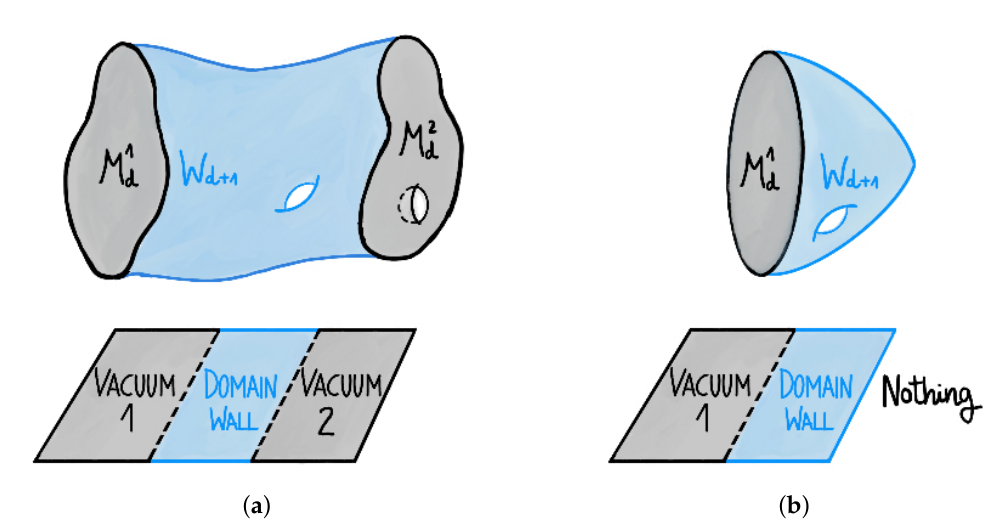
Figure 1. ( a ) Two cobordant d -dimensional manifolds, which at the level of a lower dimensional EFT give rise to a domain wall separating a theory compactified on both of them. ( b ) A d -dimensional manifold in the trivial cobordism class. Compactifying a theory in such a manifold thus supports an end of the world membrane separating it from nothing